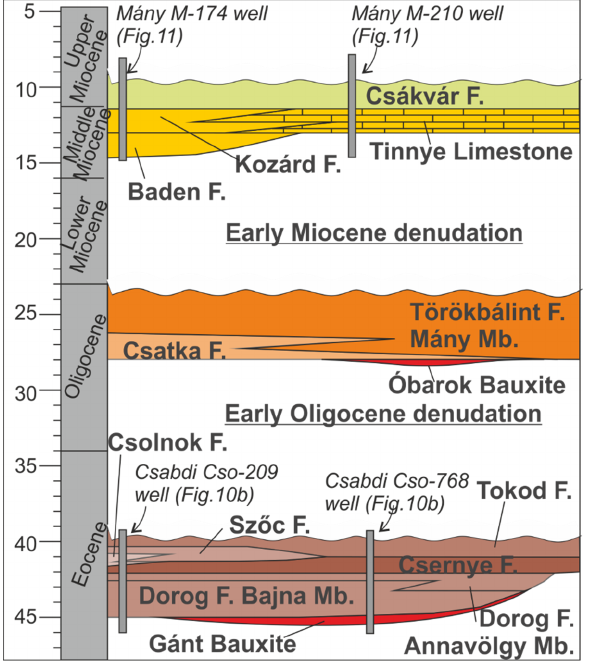
Figure 5. Cenozoic stratigraphy of the study area. The abbreviations “Fig.” refer to figures of this